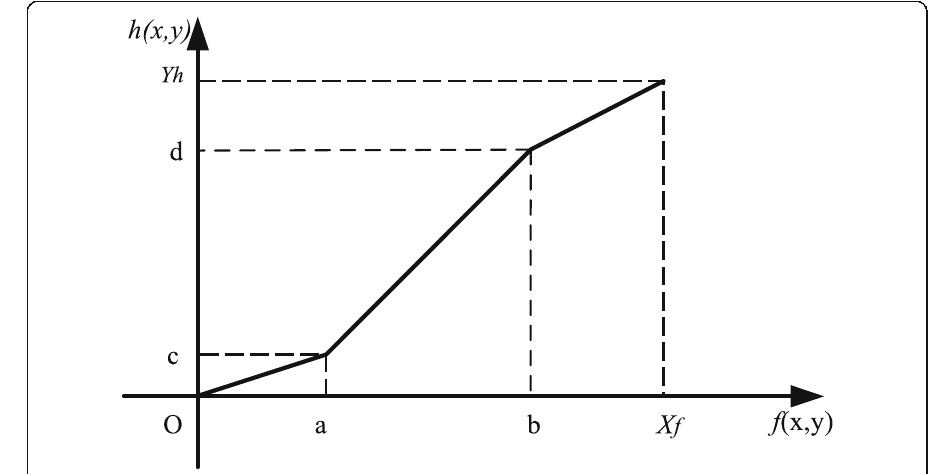
Fig. 3 Schematic diagram of the piecewise linear